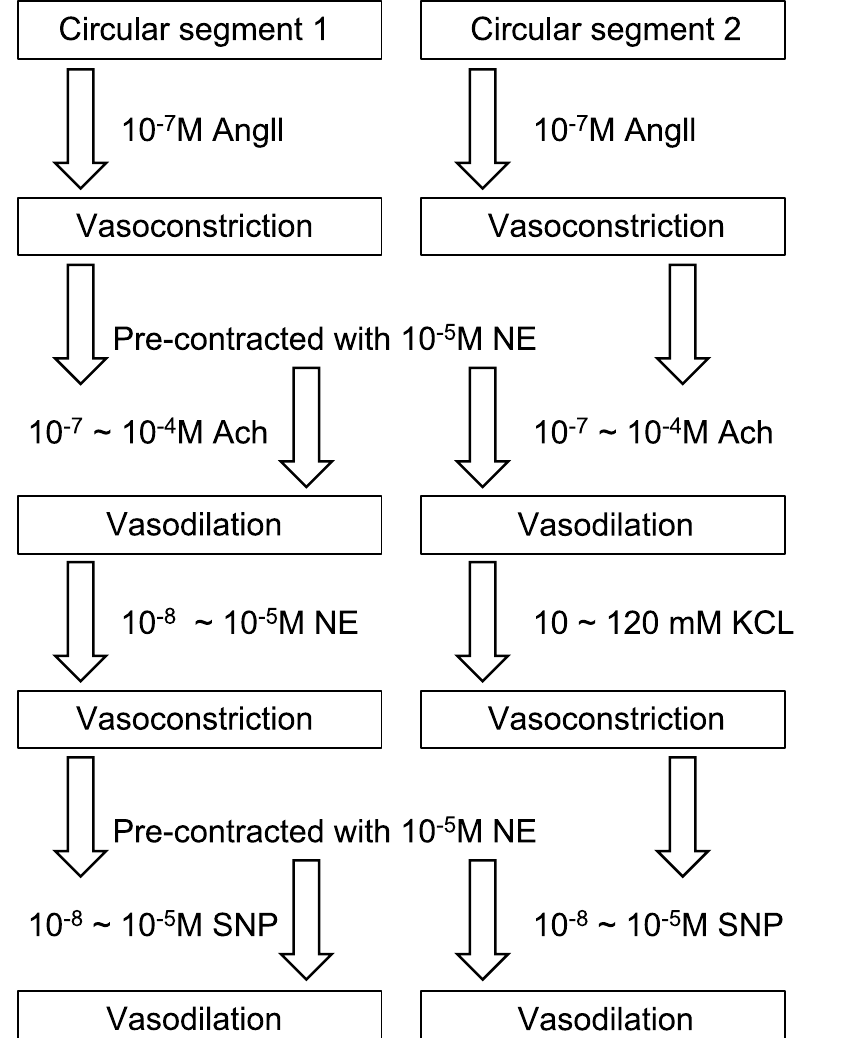
Figure 6. The flow chart of ex vivo carotid artery ring (CA) testing